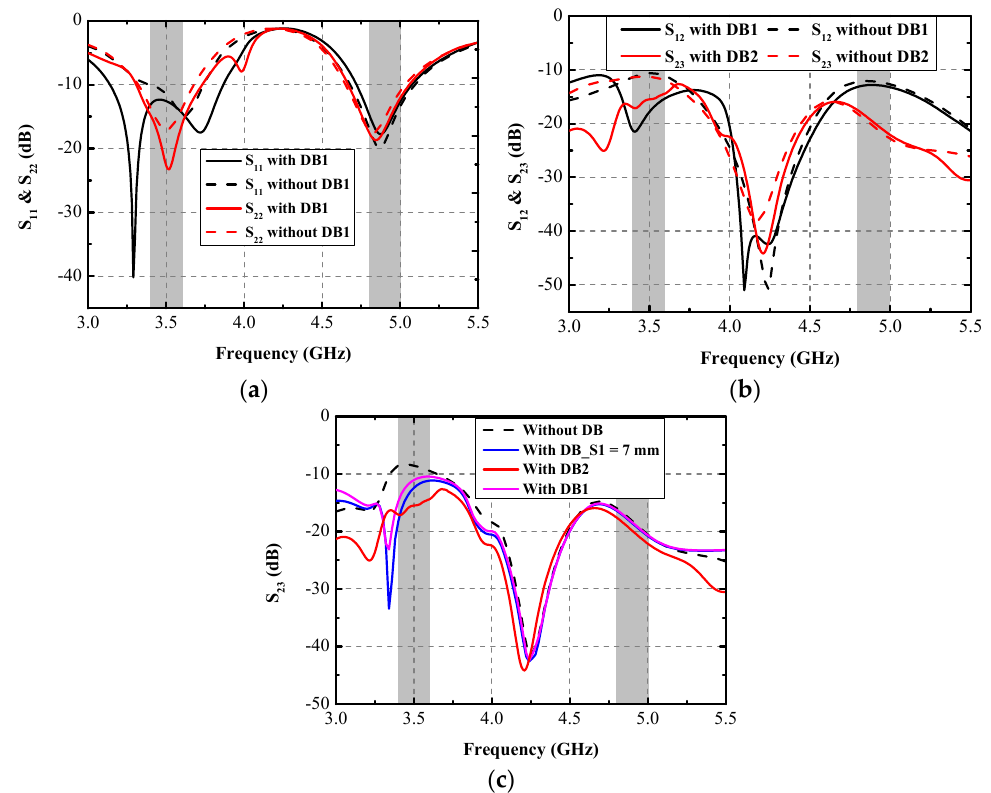
Figure 3. Simulated ( a ) S 11 and S 22 and ( b ) S 12/23 with/without DBs, ( c ) S 23 with various values of S1 .